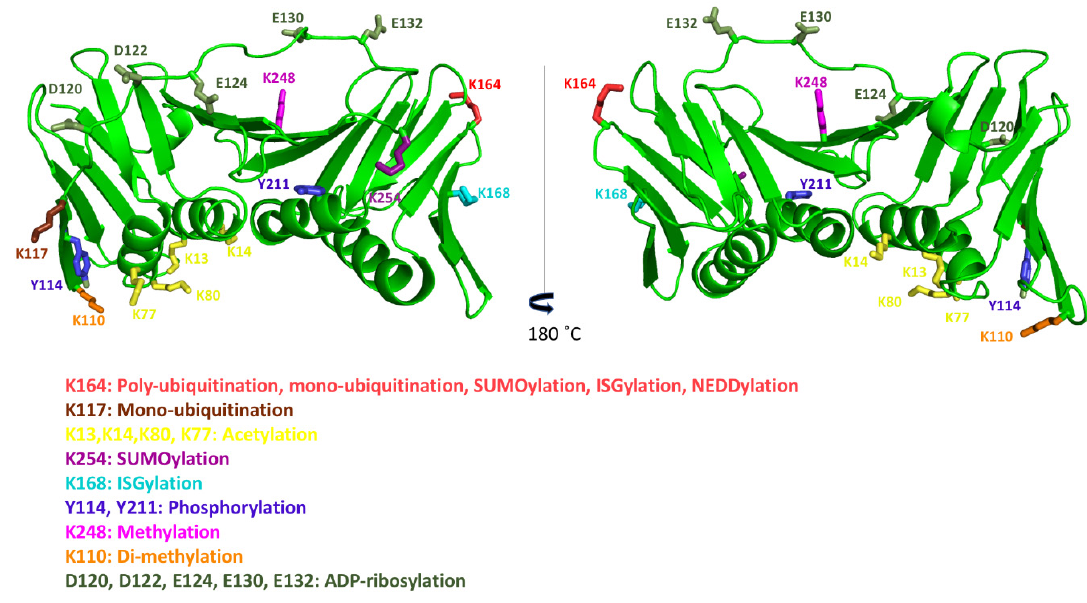
Figure 6. Residues that suffer post-translational modifications (PTMs) mapped on the crystal structure of human PCNA (PDB code: 1VYM). The front (left) and back (right) faces of the PCNA protomer are shown in cartoon representation. The side chains of residues undergoing different post-translational modifications are depicted by sticks in different colors.